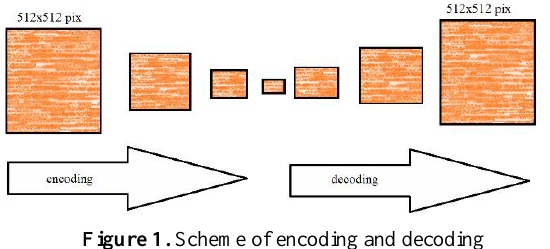
Figure 1. Scheme of encoding and